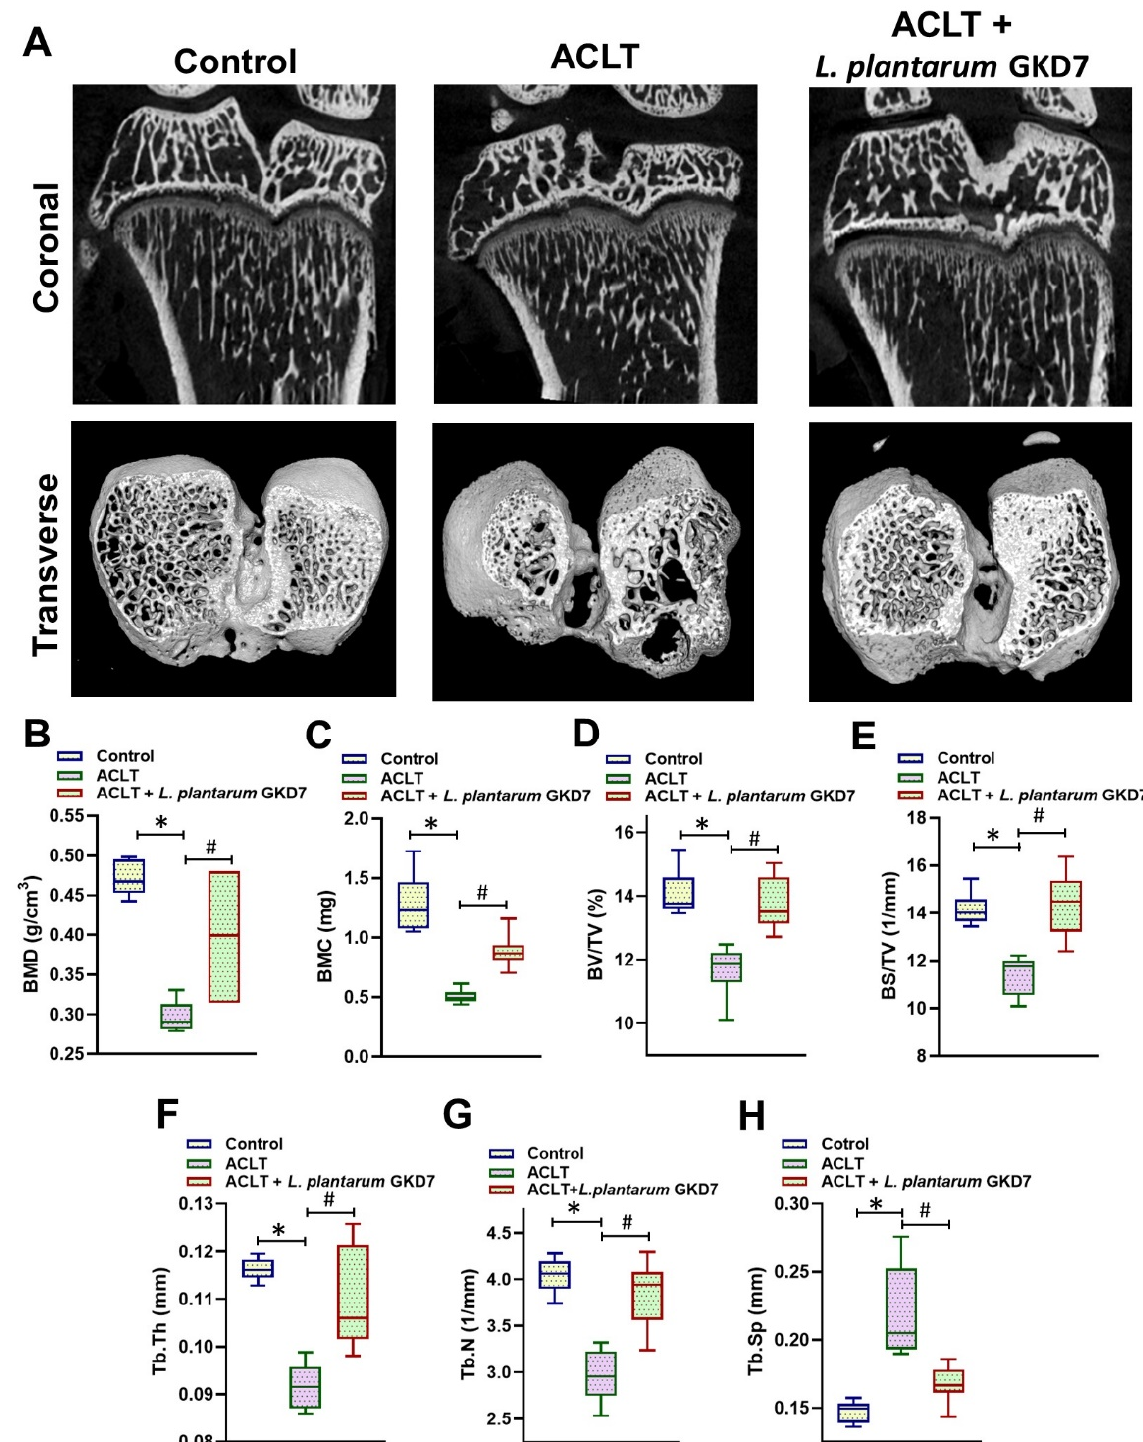
Figure 3. Representative micro-CT images of the right knee joint from rats in the sham-operated group, the ACLT-only group, and the ACLT + L. plantarum GKD7 group. ( A ) Representative coronal and transverse micro-CT images of rat knees in each study group. Quantitative analyses of ( B ) BMD, ( C ) BMC, ( D ) BV/TV, ( E ) BS/TV, ( F ) Tb.Th, ( G ) Tb.N, and ( H ) Tb.Sp. * p < 0.05 vs. controls; # p < 0.05 vs. the ACLT-only group.